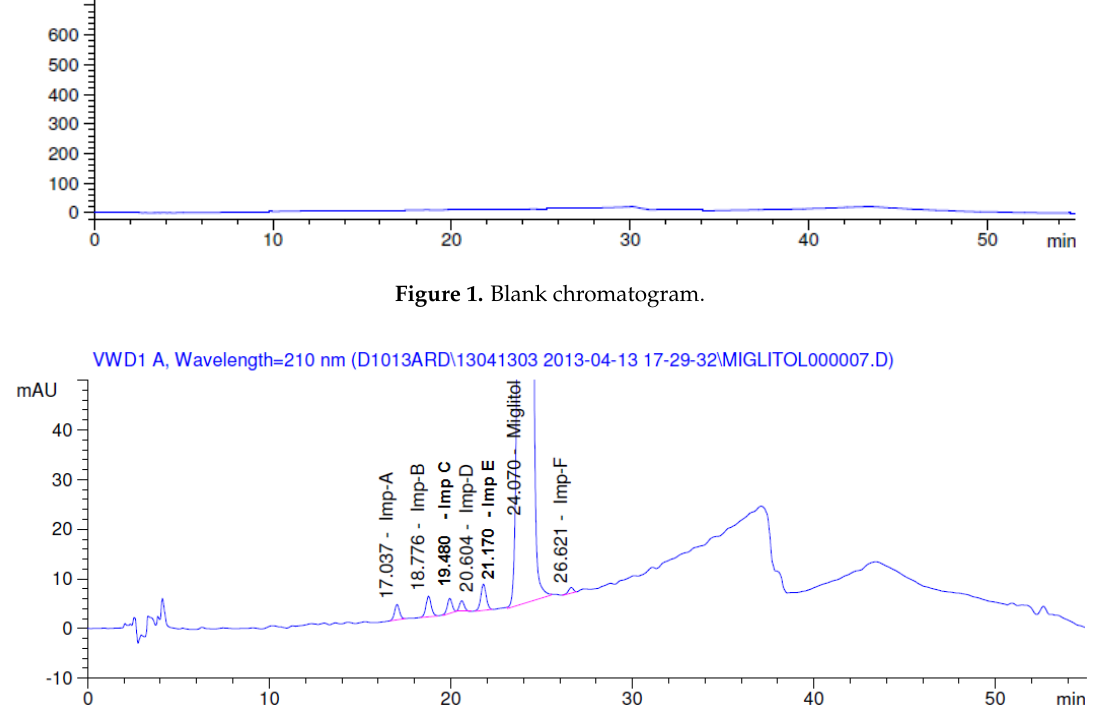
Figure 2. Typical system suitability test chromatogram. Table 1. Limit of detection (LOD), limit of quantification (LOQ), regression and precision data.